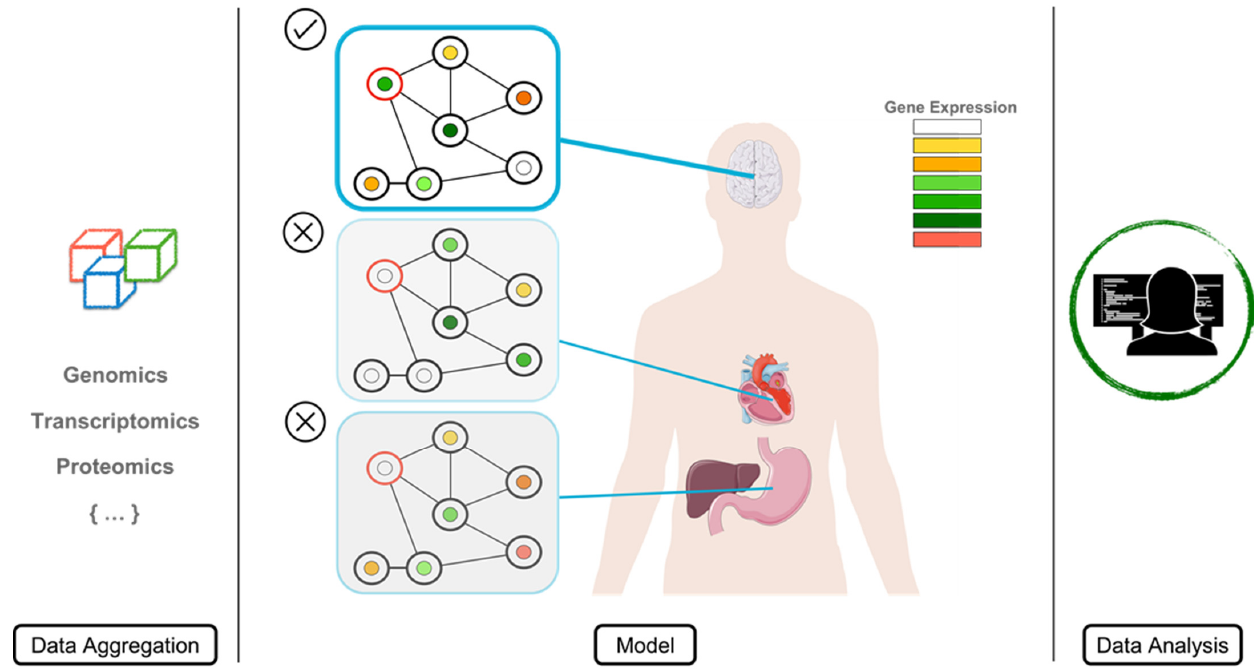
Figure 8. Multi-omics integrative analysis model.